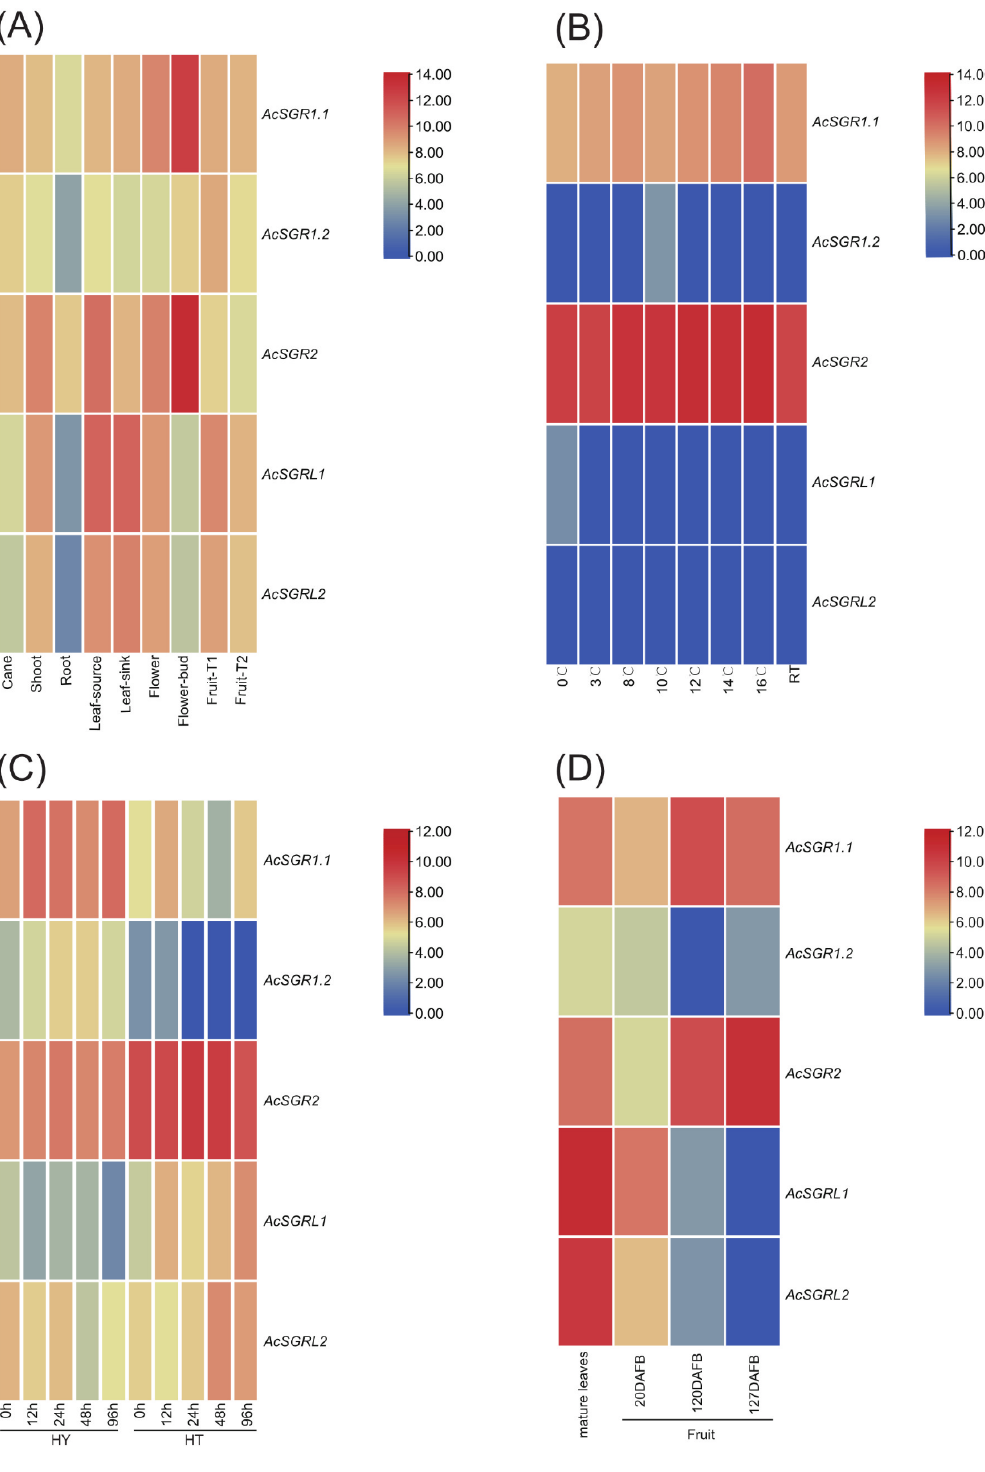
Figure 5. Expression profiles of AcSGR family members. ( A ) In different plant tissues from A. chinensis (T1: no ethylene production, T2: autocatalytic ethylene production). ( B ) In mature fruit of ‘Hort16a’ exposed to eight different temperature intervals in storage for two days. °C, degrees celsius; RT, room temperature. ( C ) In shoot of a susceptible cultivar (Hongyang, HY) and a resistant (Huate, HT) cultivar infected with Psa . The h represents the hours. ( D ) In fully expanded leaves and different fruit developmental stages of ‘Hongyang’. DAFB, days after the full bloom of fruit. The bar at the right of each heat map represents expression